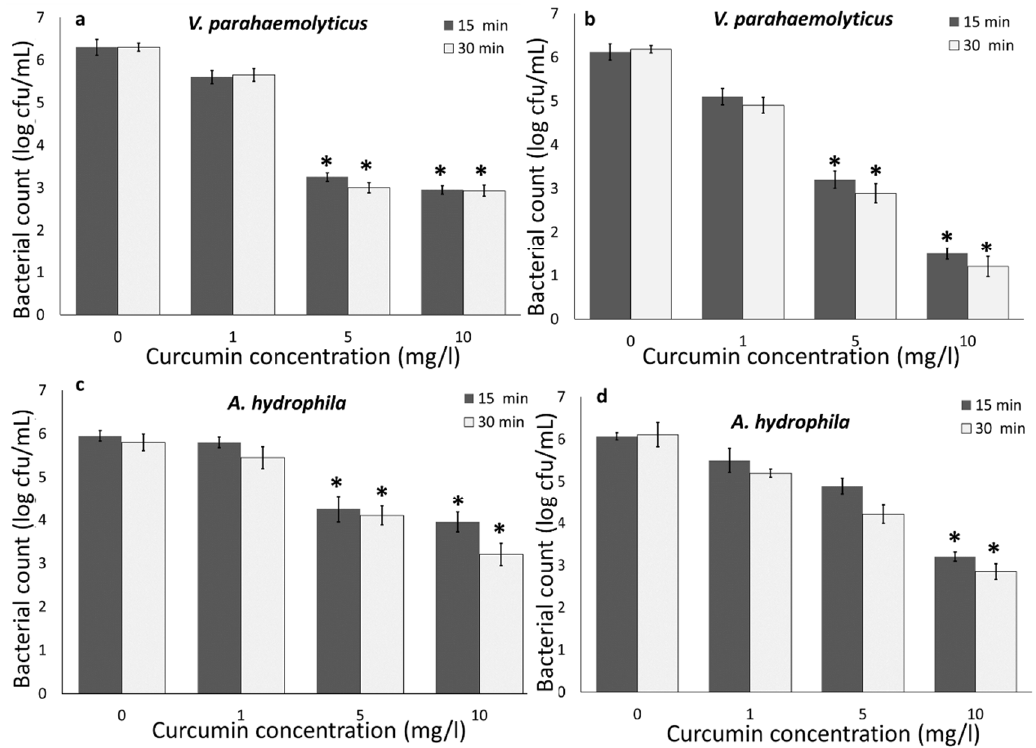
Figure 2. Effect of curcumin concentrations on the inactivation of V. parahaemolyticus at ( a ) 22 and ( b ) 4 °C, and A. hydrophila at ( c ) 22 and ( d ) 4 °C, using LED and curcumin. Statistical difference was determined based on p < 0.05 (*).